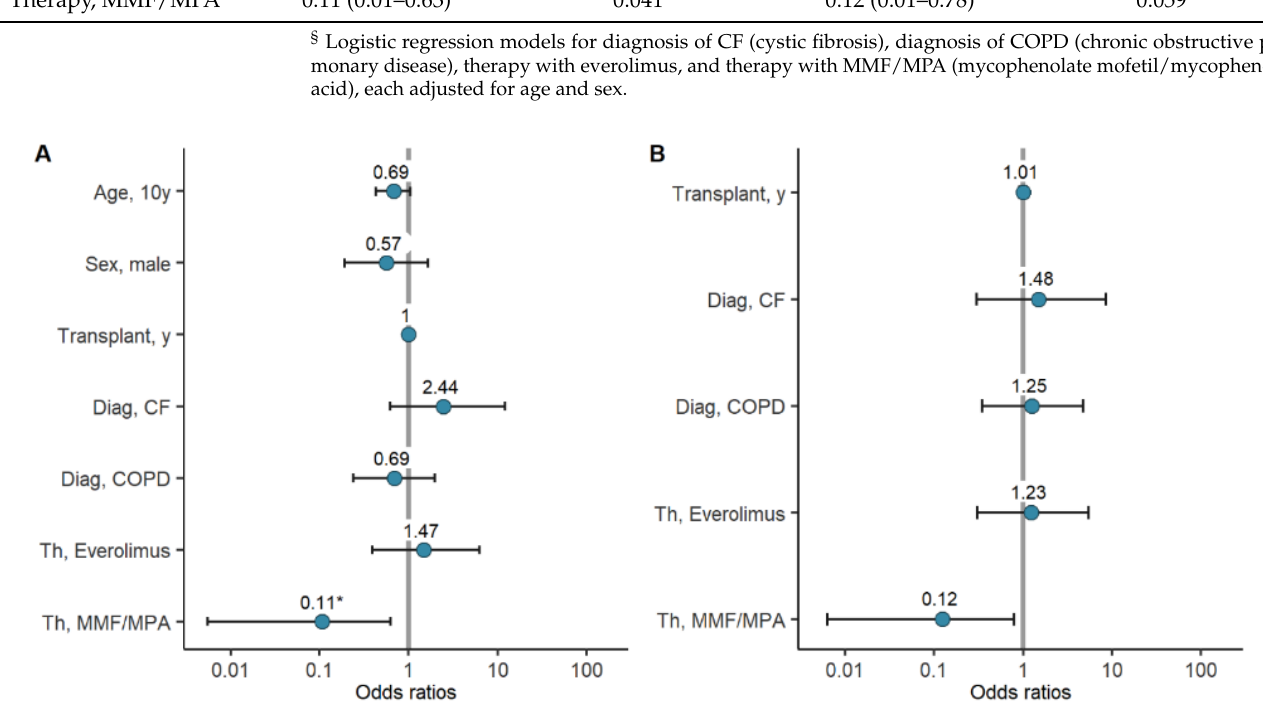
Figure 4. Logistic regression assessing seroconversion in LuTRs: univariate logistic regression including age, sex, years since lung transplantation, diagnosis, immunosuppressive therapy ( A ). Mul- tivariate logistic regression for years since lung transplantation, diagnosis, and immunosuppressive